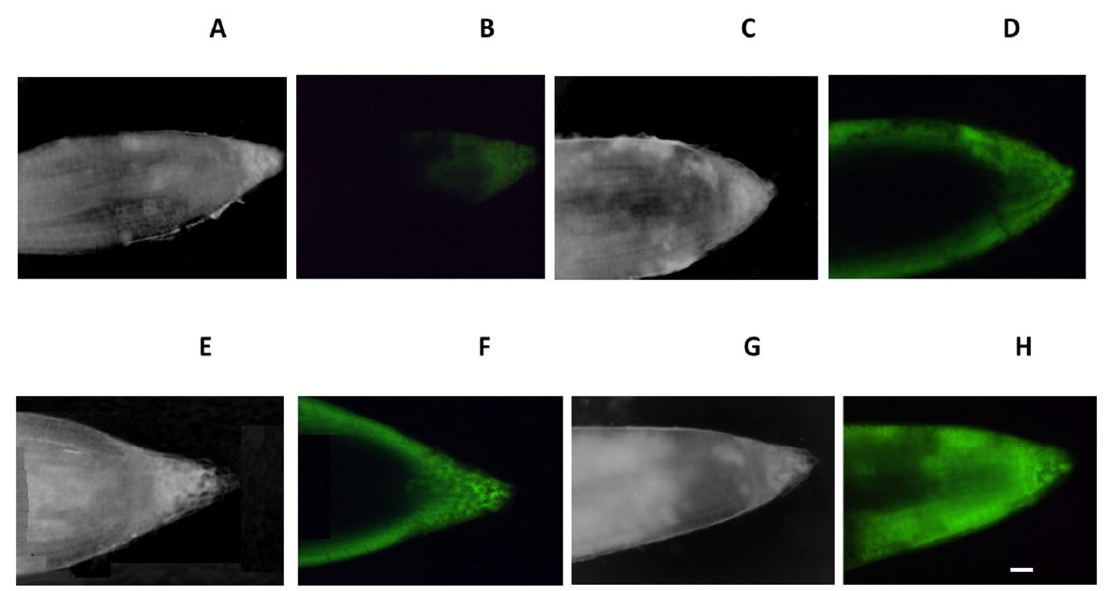
Figure 5. Distribution of ROS + and ROS − cells in the zones of 10-day wheat roots. ( A – D )—Orenburgskaya 22; ( E – H )—Zolotaya; ( A , B , E , F )—control; ( C , D , G , H )—150 mM NaCl: ( A , C , E , G )—light microscopy; ( B , D , F , H )—fluorescence microscopy, respectively. Bar 400 µ m.